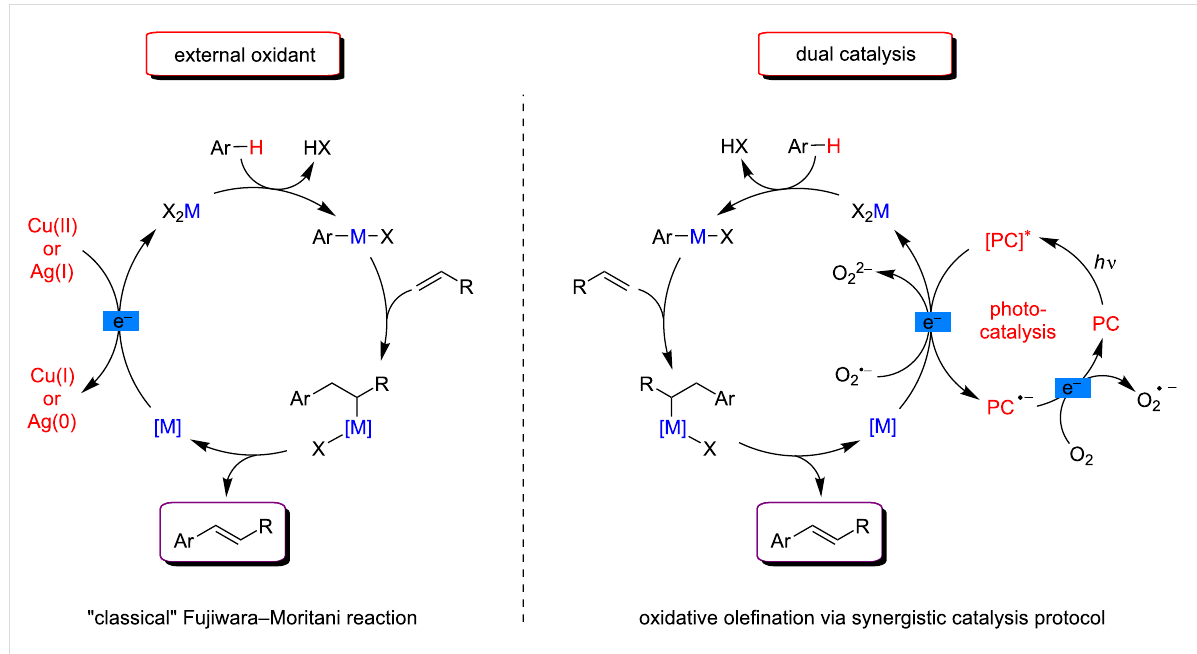
Figure 4: General mechanisms for C–H activation catalysis involving different reoxidation